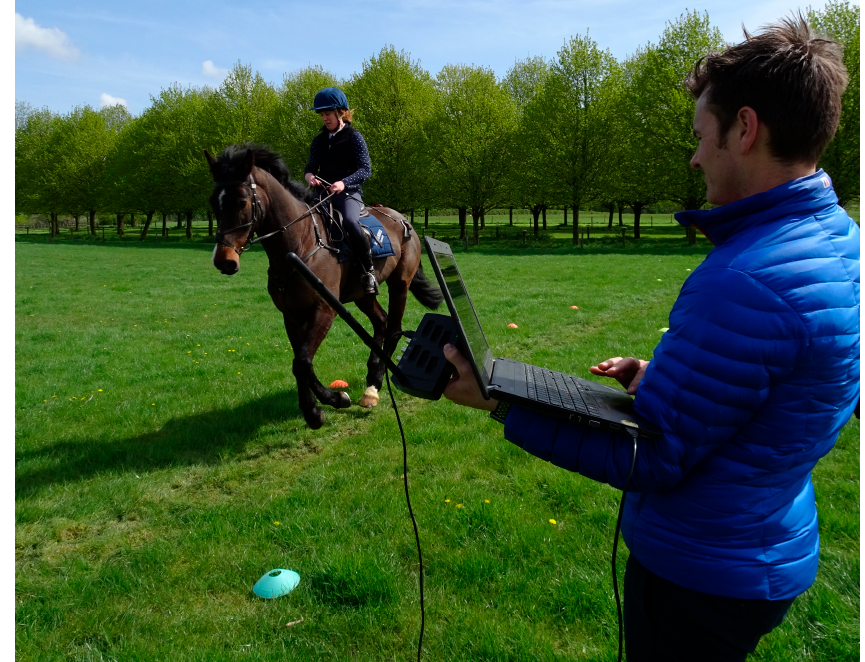
Figure 3. Equine motion analysis in progress. The horse has been instrumented with 5 triple axis inertial measurement units to monitor any changes in gait when passing over the location of the Ermine Street Roman road. The position of the test track determined from the previous geophysical survey is marked on the ground by the coloured cones.